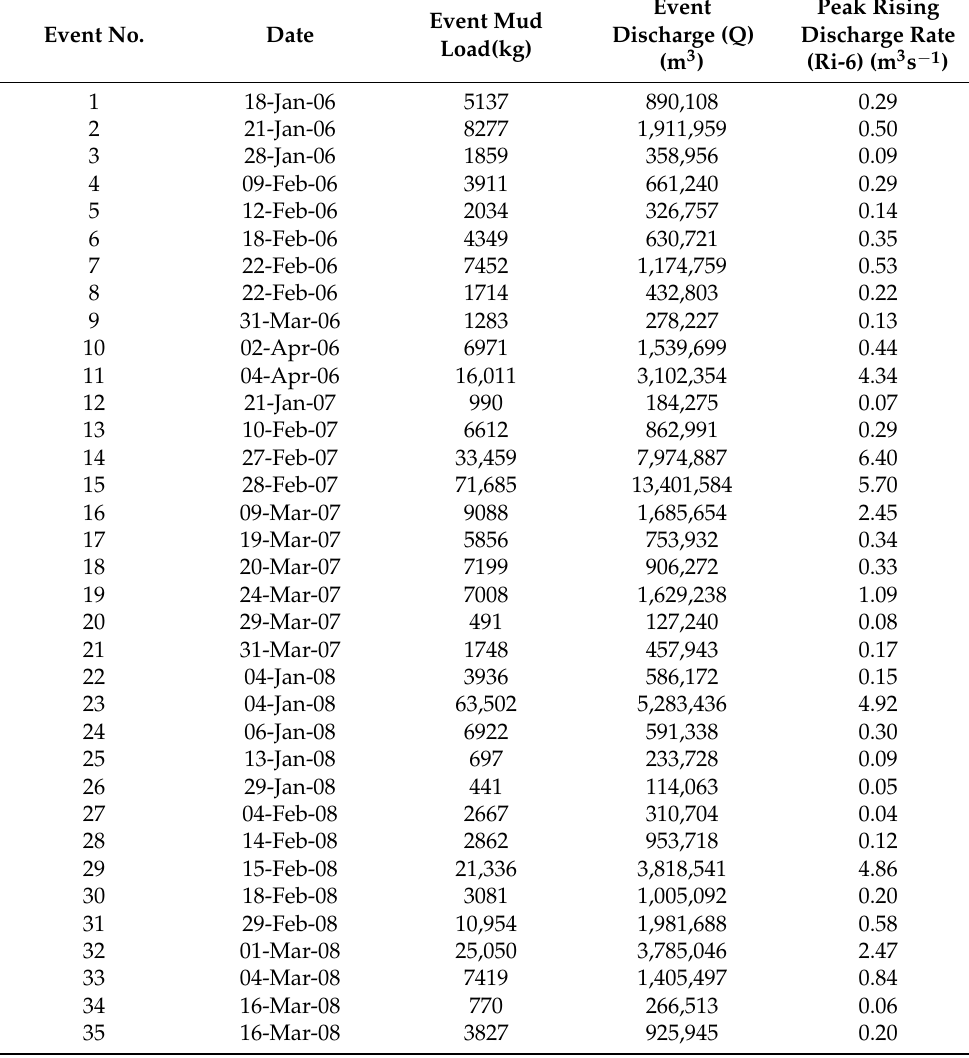
Table A1. GCDS event data